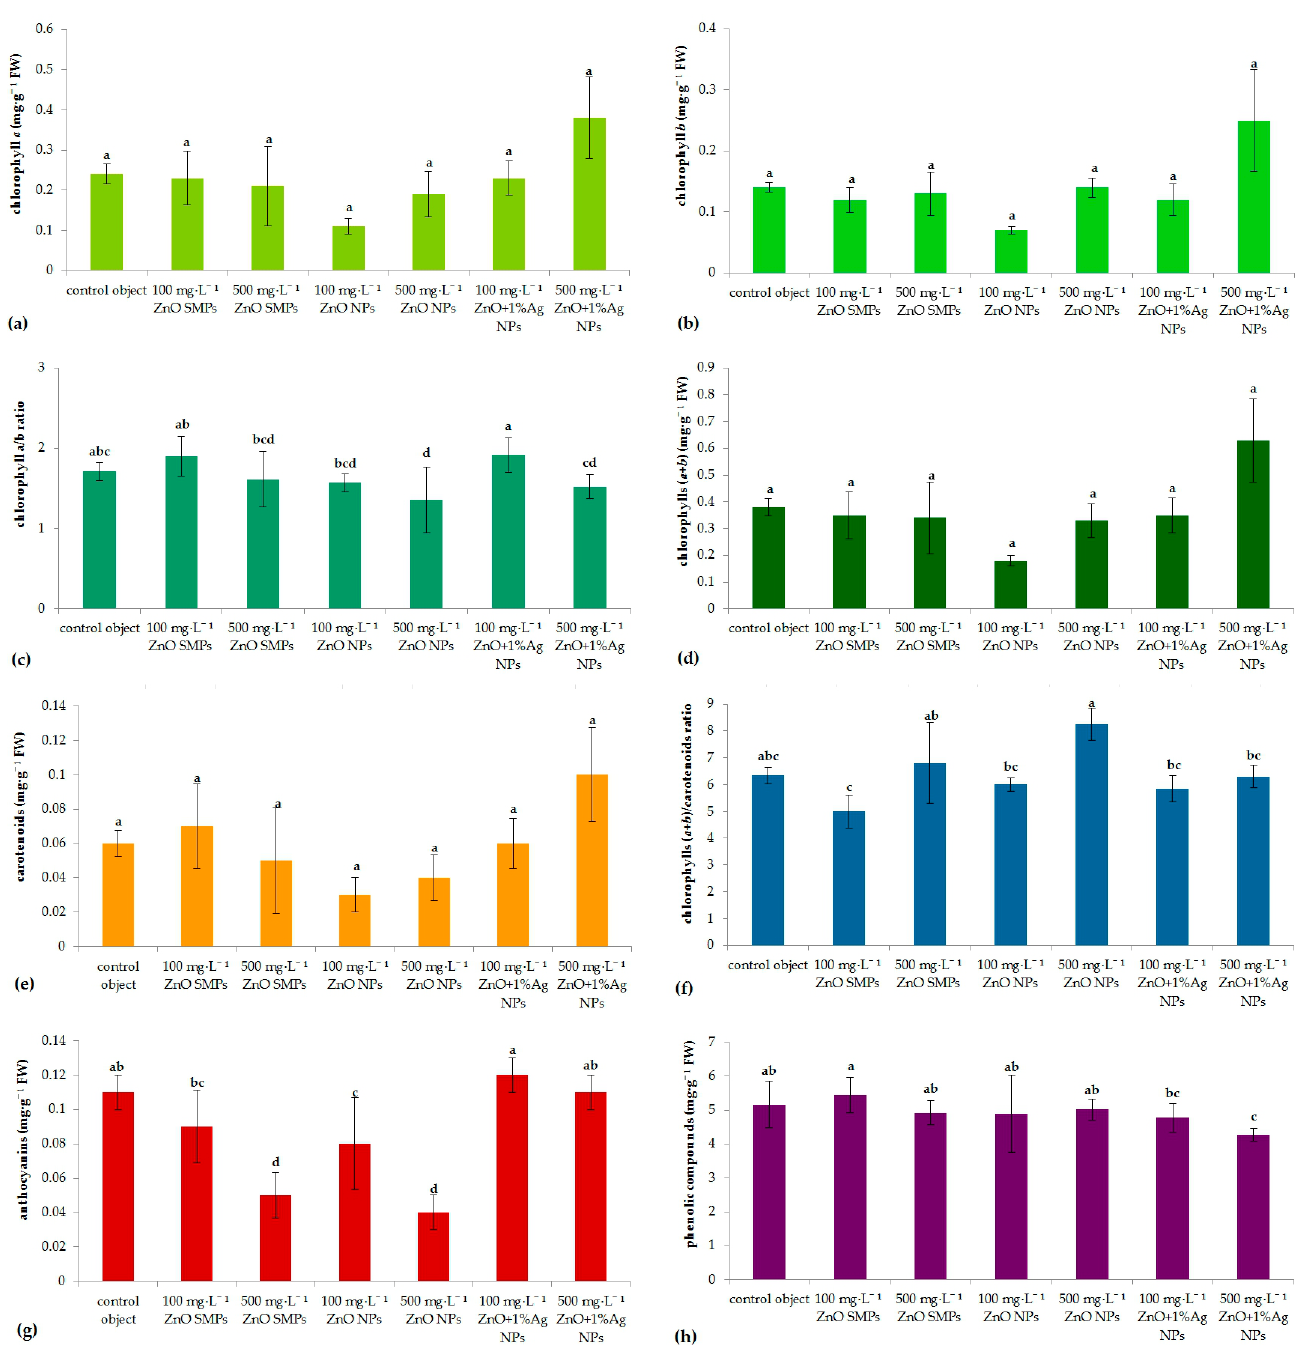
Figure 8. Content of metabolites (chlorophyll a , chlorophyll b ; ( a – d ), carotenoids, anthocyanins, phenolic compounds; ( e – h )) in adventitious shoots of Chrysanthemum × morifloium ‘UTP Pinky Gold’ regenerated from internodes cultured in vitro for 9 weeks on the modified MS medium with 0.6 mg ∙ L − 1 BAP and 2 mg ∙ L − 1 IAA, depending on the experimental treatment. Means ± SD on graphs followed by the same letter do not differ significantly at p ≤ 0.05 (Fisher’s test).